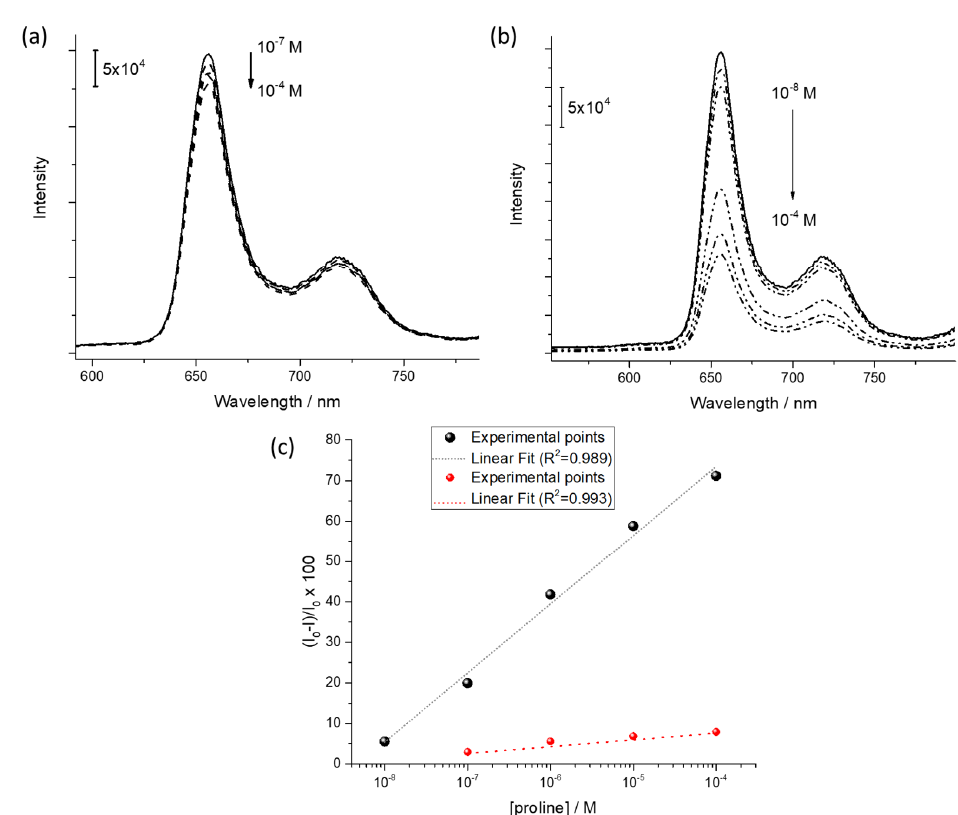
Figure 5. Quenching induced by ( a ) D-proline flux and ( b ) L-proline flux on fluorescence emission of H 2 PL(-) LS film. ( c ) Logarithmic relation between the fluorescence quenching and the L-proline (black dots) and D-proline (red dots) concentration.